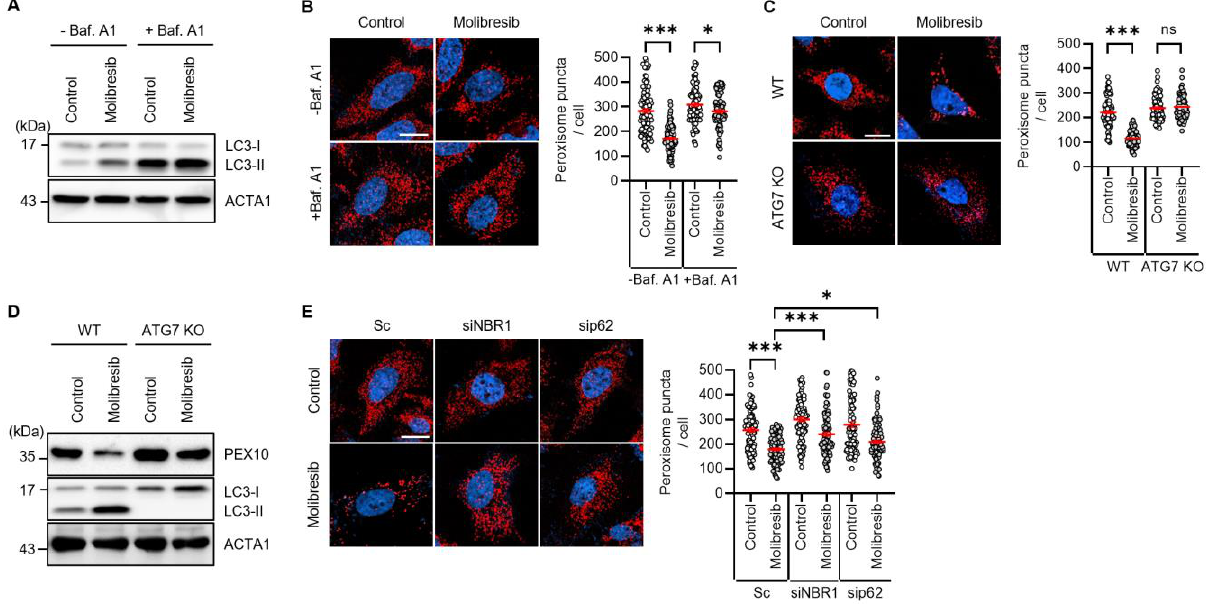
Figure 2. Loss of ATG7 blocks molibresib-induced pexophagy in HeLa cells. ( A , B ) HeLa cells pre- treated with molibresib (10 µM) for 48 h were further incubated with or without bafilomycin A1 (Baf. A1, 25 nM) for 6 h. Then, the cells were harvested to analyze by Western blotting with indicated antibodies ( A ); the cells were stained with anti-ABCD antibody (red) and Hoechst 33,342 (blue). The number of peroxisomes per cell was calculated by assessing > 100 cells ( B ); ( C ) wild-type and ATG7- knockout HeLa cells were treated with molibresib (10 µM) for 48 h. The cells were stained with anti- ABCD3 antibody (red) and Hoechst 33,342 dye (blue). The number of peroxisomes per cell was cal- culated by assessing approximately 100 cells; ( D ) wild-type and ATG7-knockout HeLa cells were treated with molibresib (10 µM) for 48 h, and then harvested for analysis by Western blotting with the indicated antibodies; ( E ) HeLa cells were transiently transfected with scrambled siRNA (Sc) or validated siRNA targeting for NBR1 (siNBR1) or p62 (sip62). After 24 h, the cells were further treated with molibresib (10 µM) for 48 h and stained with anti-ABCD3 antibody (red) and Hoechst 33,342 dye (blue). The number of peroxisomes per cell was calculated by assessing approximately 100 cells; the scale bar indicates 20 µm. (Data indicate means S.E.M. * p < 0.05, *** p < 0.001, ns: not significant).